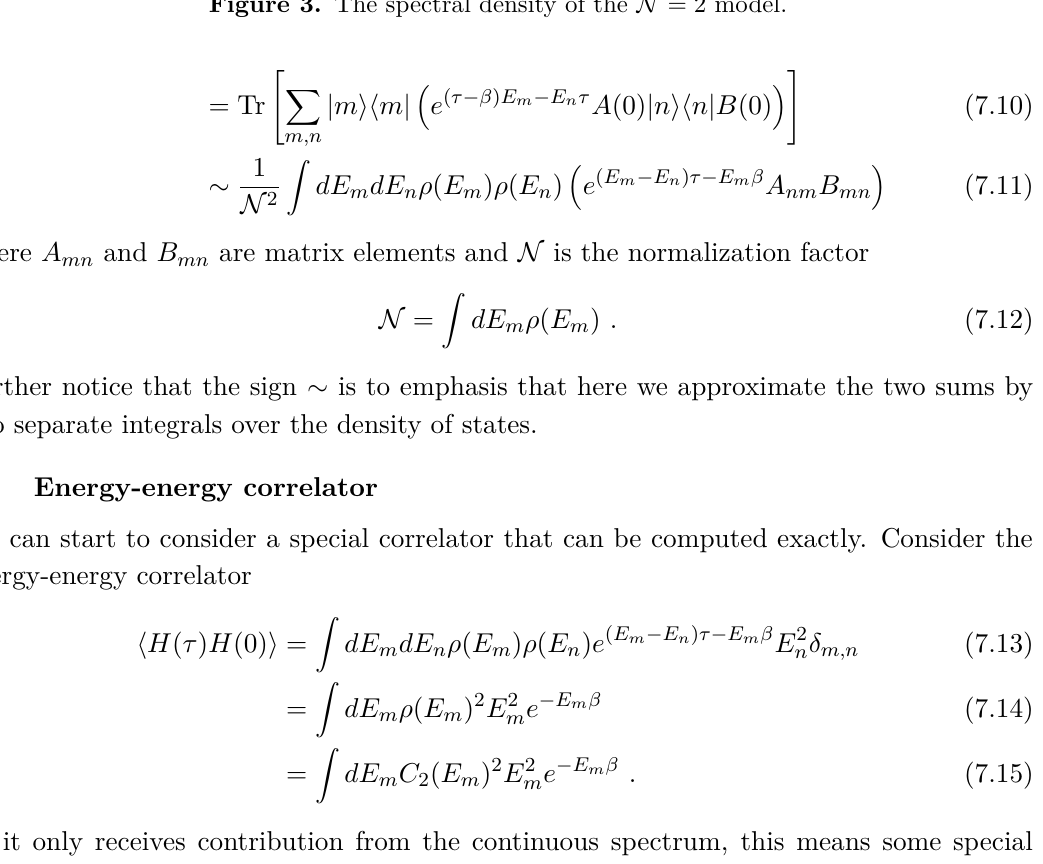
(b) The spectral density for odd N . The red and blue curve are Λ = 20 and Λ = 60 respec- and blue curve are Λ = 20 and Λ = 60 respec- tively. The plot is computed at q = 3 , C = 1 . tively. The plot is computed at q = 3 , C = 1 . Figure 3. The spectral density of the N = 2